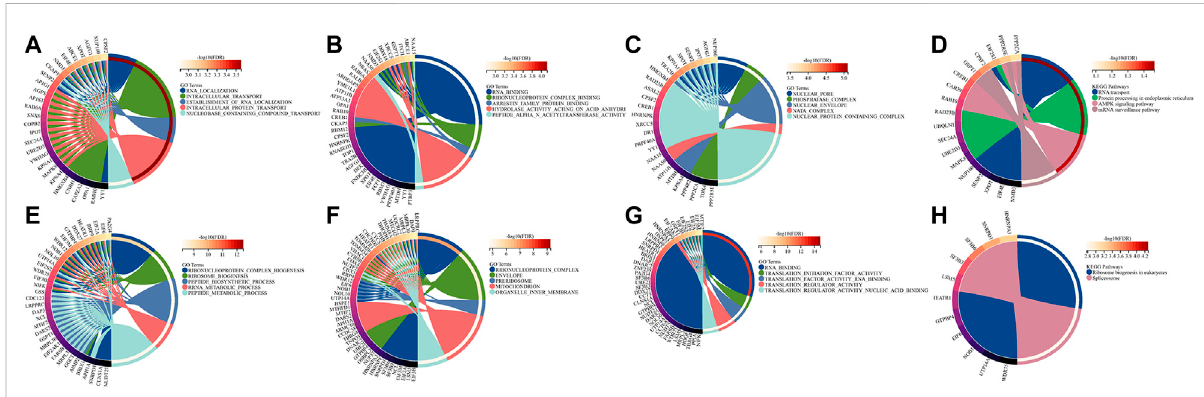
FIGURE 6 Circos plots displayed the results of GO and KEGG analyses for BZW1, BZW2 and their similar genes. (A) BZW1 GO BP. (B) BZW1 GO MF. (C) BZW1 GO CC. (D) BZW1 KEGG. (E) BZW2 GO BP. (F) BZW2 GO CC. (G) BZW2 GO MF. (H) BZW2